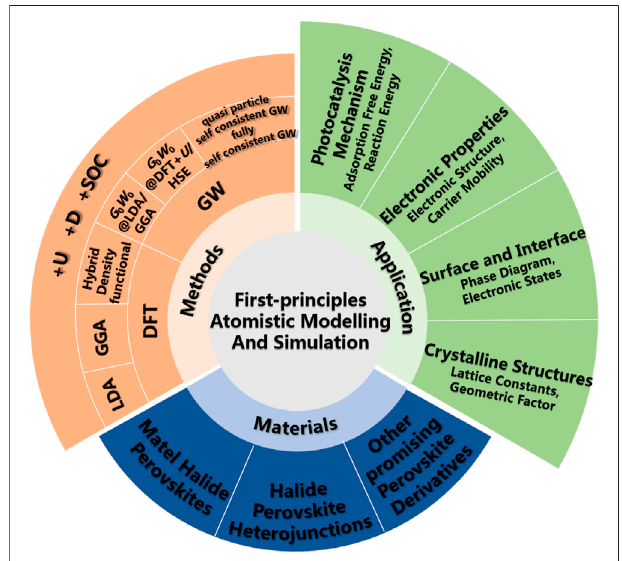
FIGURE 1 | Applications of fi rst-principles atomistic modeling and simulation in halide perovskite-based